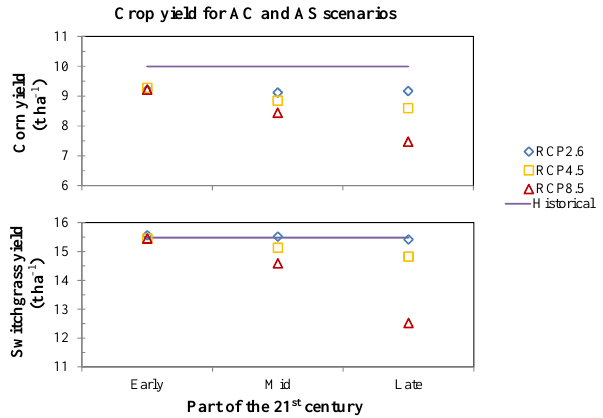
Figure 5. Watershed average crop yield for corn and switchgrass using all corn (AC) and all switchgrass (AS) agricultural scenarios,